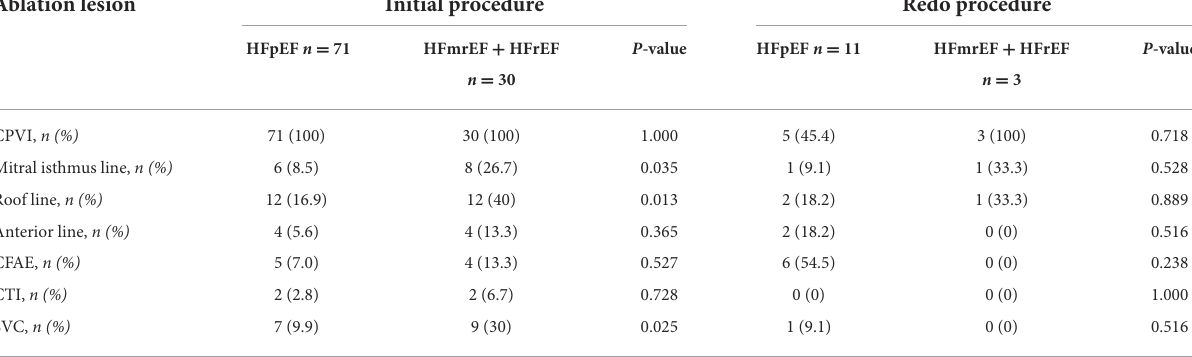
TABLE 2 The ablation details of the initial and redo